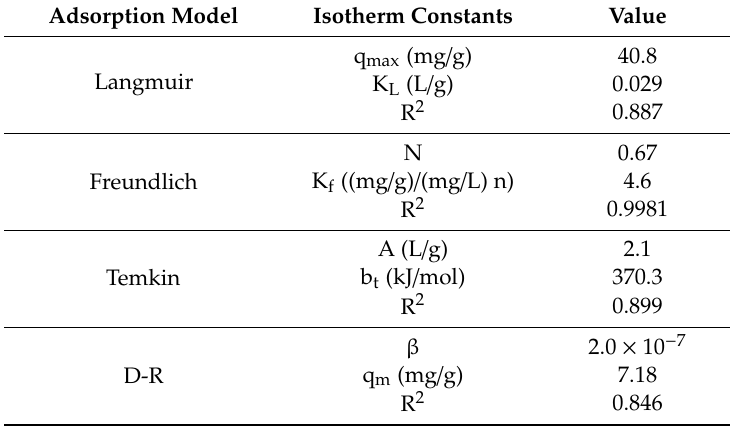
Table 3. Parameters obtained from various isotherm